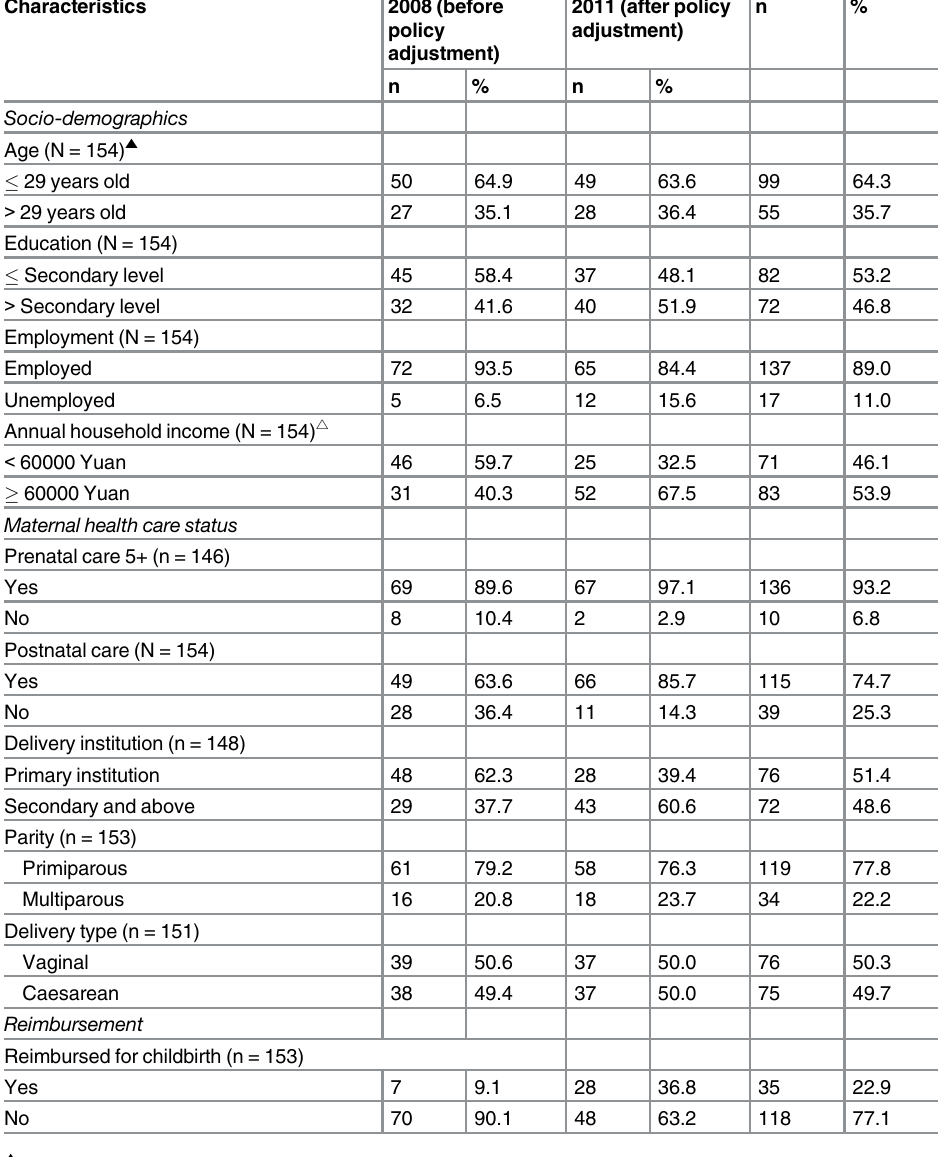
Table 1. Participants ’